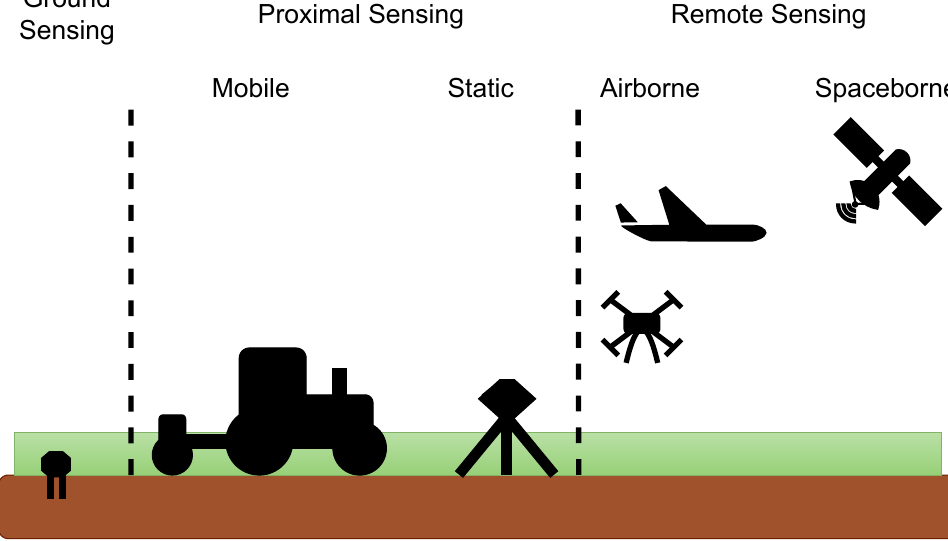
Figure 1. Classification of soil moisture measurement methods: Ground sensing (left), mobile or static proximal sensing (middle), and airborne or spaceborne remote sensing techniques